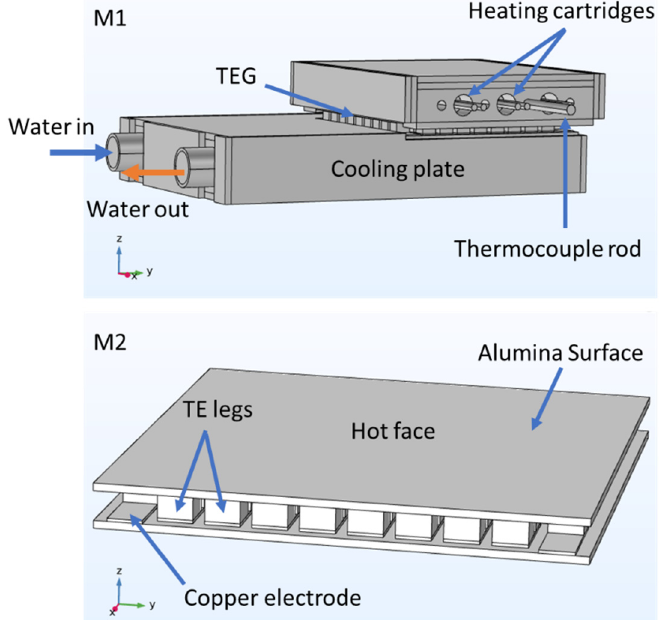
Figure 2. The 3D CAD geometries used to simulate the whole testing system (M1) and a TE module (M2).